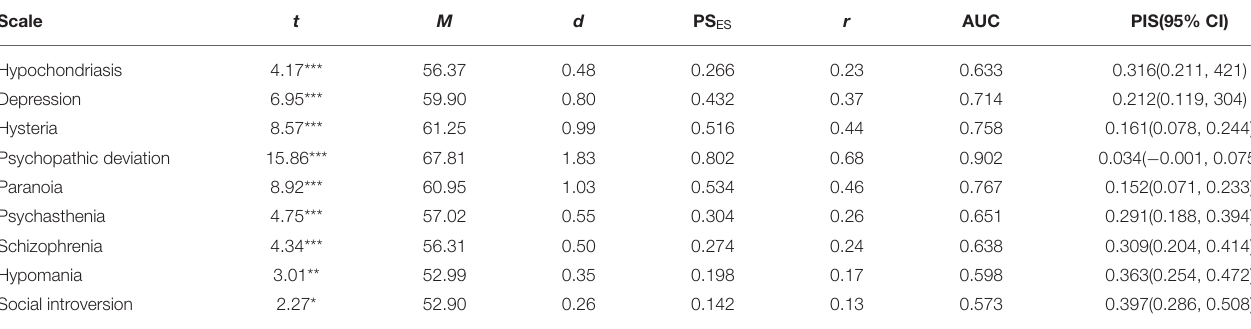
TABLE 2 | One-sample t -test for the comparison of CPOs with the mean of the normative population as test value ( T = 50) in the basic clinical scales. Scale